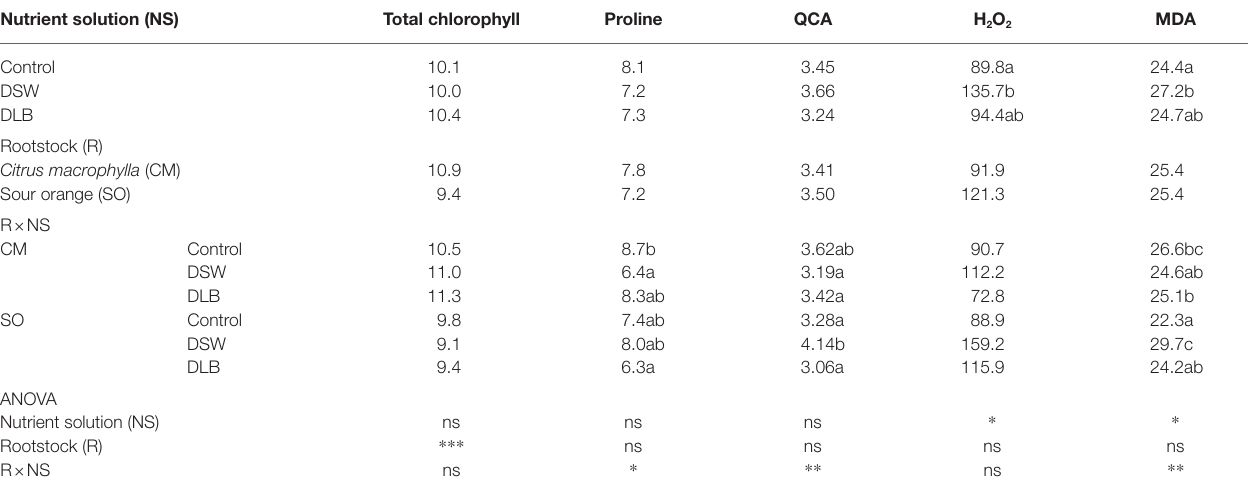
TABLE 7 | Effects of 7 months of irrigation with nutrient solutions of different characteristics—Control, DSW, and DLB—and the rootstock on H 2 O 2 , malondialdehyde (MDA), proline, and quaternary ammonium compounds (QAC) accumulation and the total chlorophyll in leaves of ‘Verna’ lemon plants grown on two rootstocks, Citrus macrophylla (CM) and sour orange